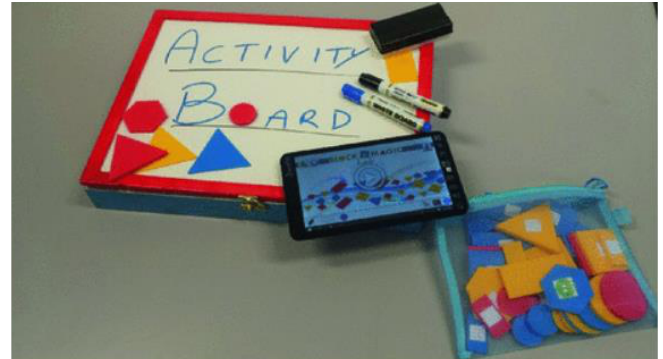
Figure 19. Activity Board 1.0 consists of a wooden box with a radiofrequency identification (RFID) reader and a RFID antenna, tablet, and tangible objects with RFID tags [37].